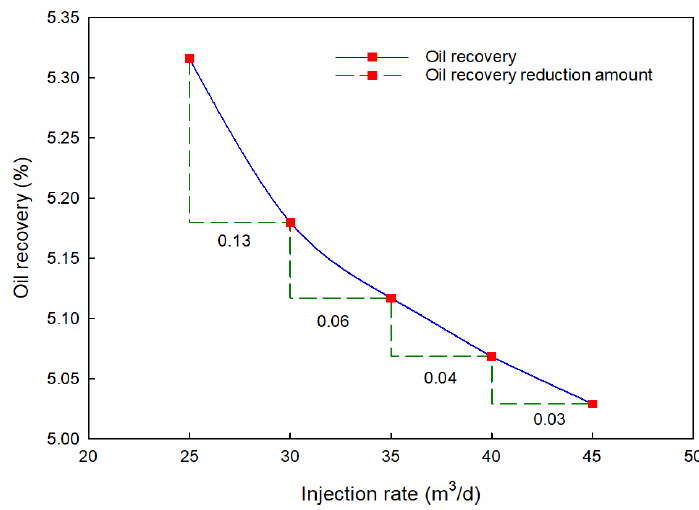
Figure 7. Oil recovery with different injection rates.